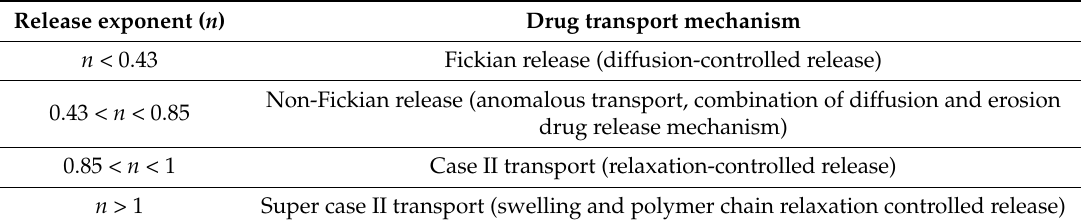
Table 2. Drug release mechanism according to n value from Korsmeyer-Peppas